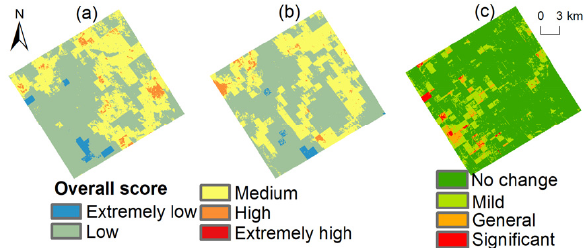
Figure 5. Comprehensive assessment of ecological changes in the control plot of the Wuliangsuhai watershed: ( a , b ) are the ecological scores for 2017 and 2021, respectively; ( c ) is a comprehensive assessment of changes in ecological conditions.